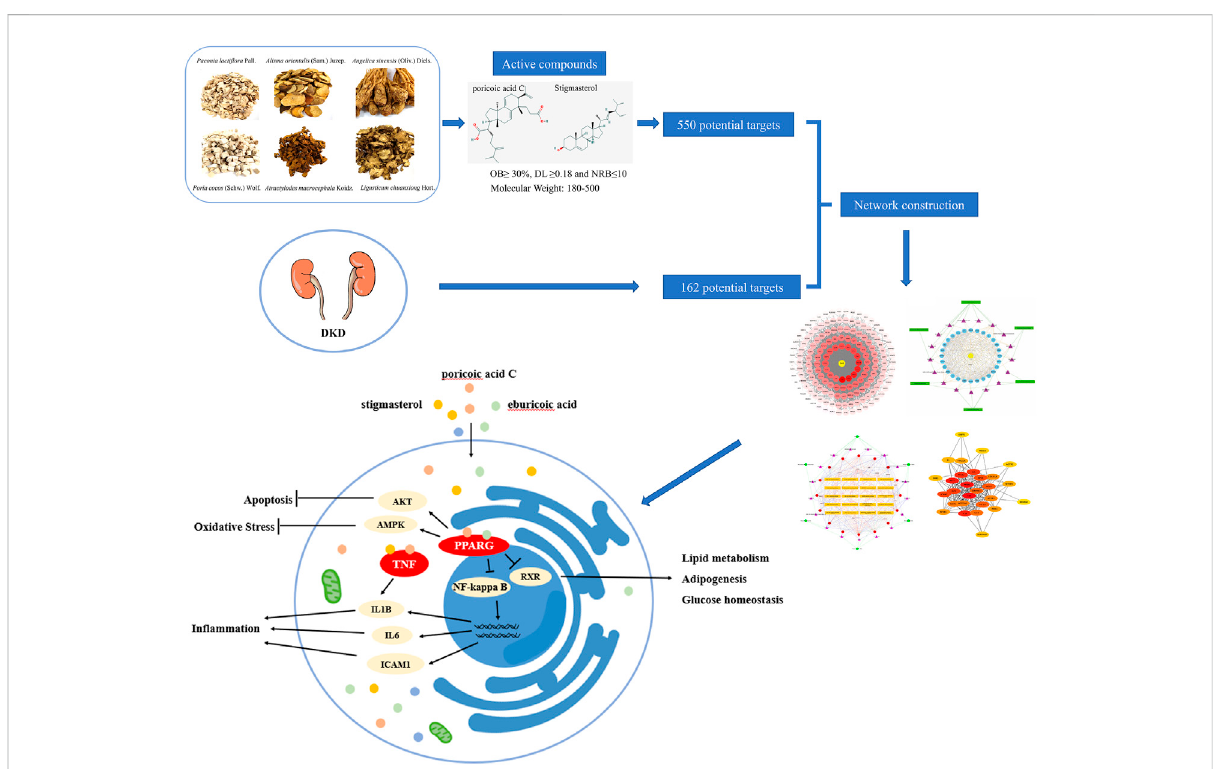
FIGURE 10 Schematic diagram of the network pharmacology for the pharmacological mechanisms of DSS for treatment of